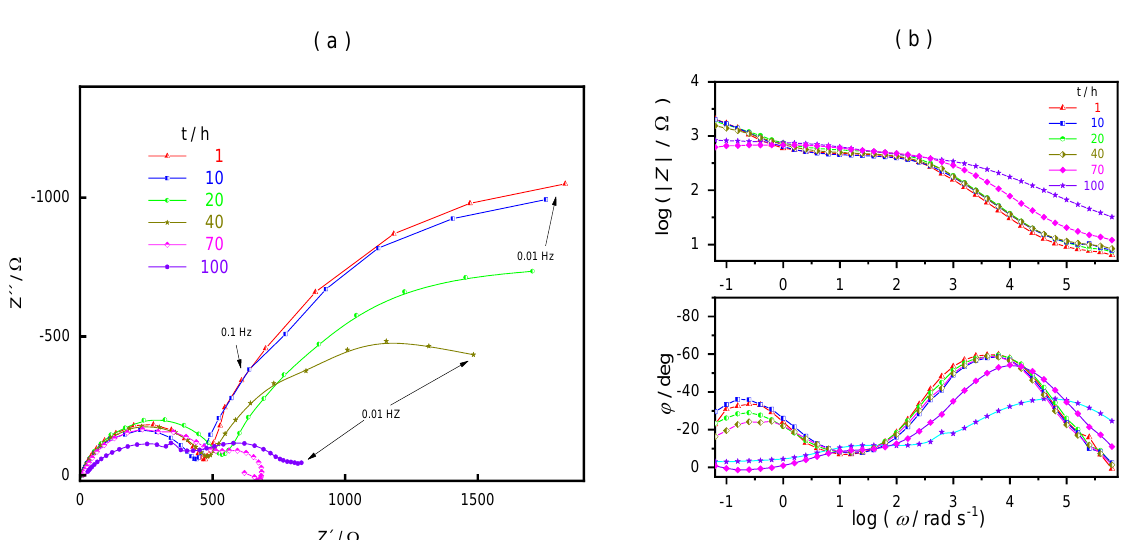
Figure 7. In situ GEIS impedance spectra for HCSi40 electrode in ( a ) Nyquist plot, ( b ) Bode plot. Figure 8 shows the time dependent GEIS impedance spectra for the thickest layer HCSi60. The presence of an LF semicircle throughout the galvanostatic process indicates that the resistive component dominates all the time. There is hard intercalation of Li + ions into the bulk and cannot eliminate the resistive component of the layer. Intercalation oc- curs in a single process (Figure 4) that changes only after 60 h, but the Li + ions continue to have difficulty penetrating deeper into the electrode.